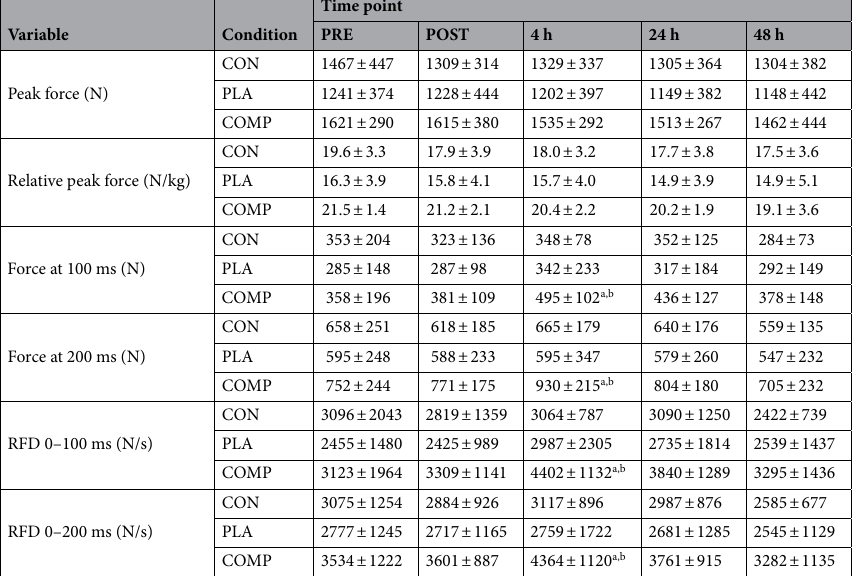
Table 3. Isometric mid-thigh pull (IMTP) measures for CON, PLA and COMP conditions. Measures include peak force, relative peak force, force at 100 ms and 200 ms, and rate of force development (RFD) at 100 ms and 200 ms. Time points are before exercise (PRE), immediately post-exercise (POST), and 4, 24, and 48 h post-exercise. All data presented as mean ± SD. a Medium effect as compared with CON. b Medium effect as compared with